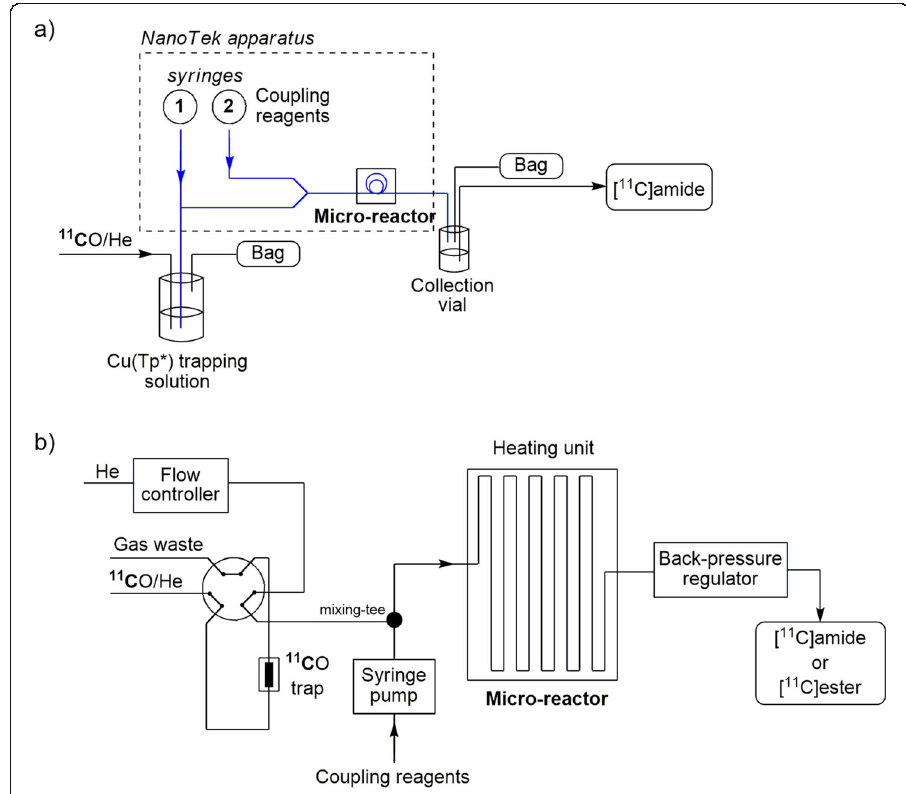
Fig. 13 Pd-Mediated syntheses of: a [ 11 C]amides in a microfluidic reactor; b [ 11 C]amides and [ 11 C]esters in a gas-liquid microfluidic